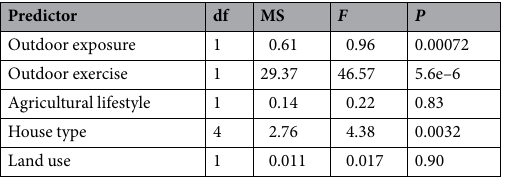
Table 3. Model for several factors in association to allergy score. Breed and sex were set as random factors (sex nested in breed). The outdoor exposure, outdoor exercise and house type remained significant predictors of allergy score when factors mentioned in table were included in the same analysis.